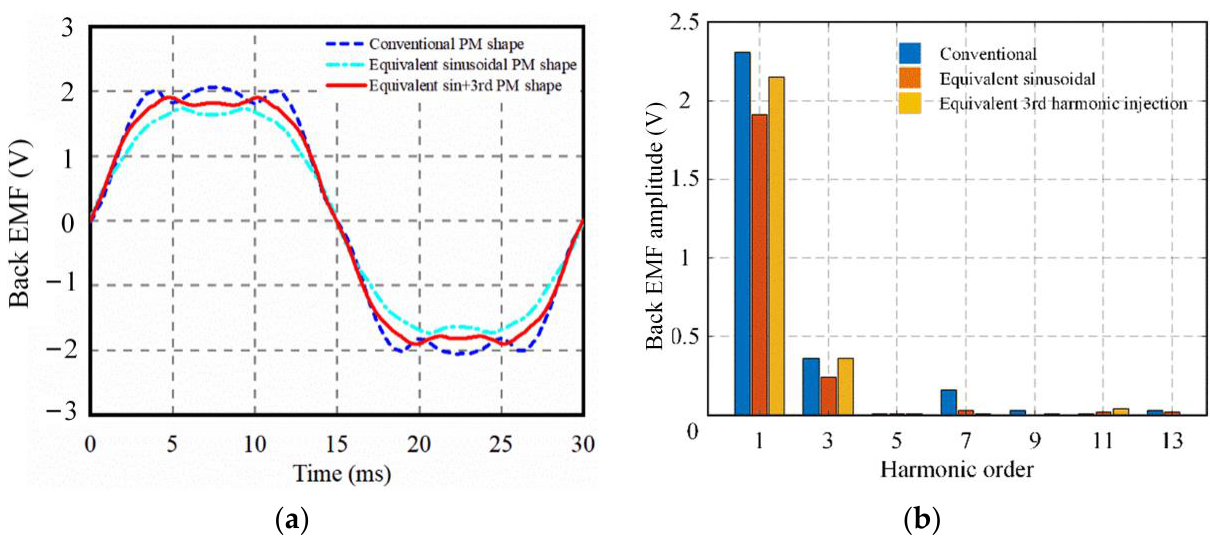
Figure 12. No-load back EMF waveform and harmonic distribution: ( a ) Back-EMF waveform; ( b ) harmonic distribution.